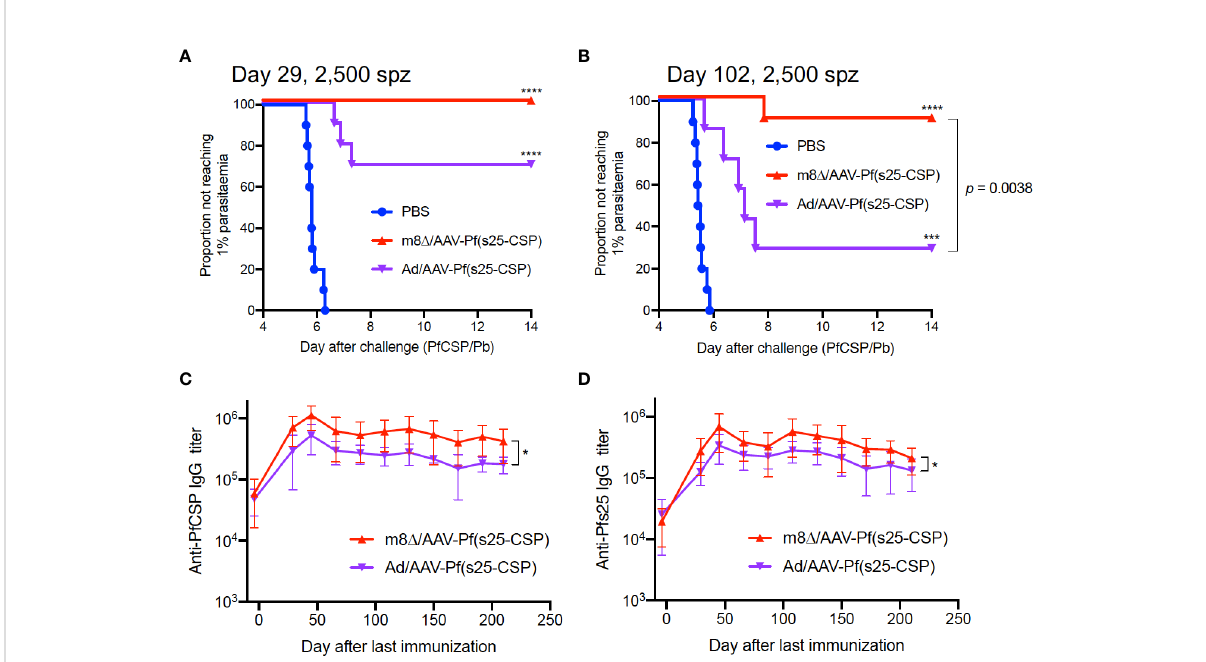
FIGURE 2 Protective ef fi cacy against high-dose sporozoites. (A, B) Protective ef fi cacy in Balb/c mice immunized with m8 D /AAV-Pf(s25-CSP) (n = 10 for both short-term and long-term studies) and Ad/AAV-Pf(s25-CSP) (n = 10 for short-term and n = 7 for long-term studies) after challenge with 2,500 PfCSP/Pb sporozoites. Sporozoite challenges were conducted at day 29 (A) , short-term) and day 102 (B) , long-term) after the last immunization. P values were calculated by log-rank (Mantel – Cox) tests versus the PBS group or each vaccine group. (C, D) IgG antibodies against PfCSP (C) and Pfs25 (D) in the protected mice in (A) were periodically monitored. P values were calculated by repeated measures two- way ANOVA with Sidak ’ s multiple comparisons test for the vaccine type. *p < 0.05; ****p <